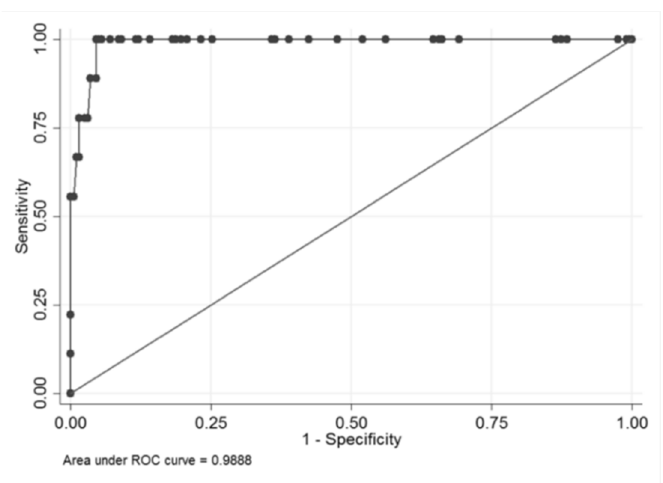
Figure 5. Area under the receiver operating characteristic (ROC) curve (AUC) of 98.9%.